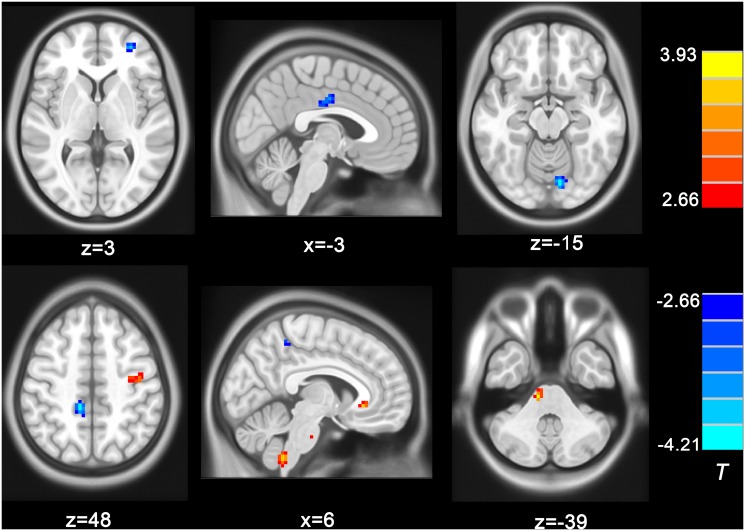
Clusters showing significant ReHo differences between two groups.The cold colors indicate lower ReHo in HFS group than healthy control group, while the warm colors mean vice versa (p < 0.05, AlphaSim corrected). Color bars represent the t value of the group analysis. Left in the figure indicates the right side of the brain.